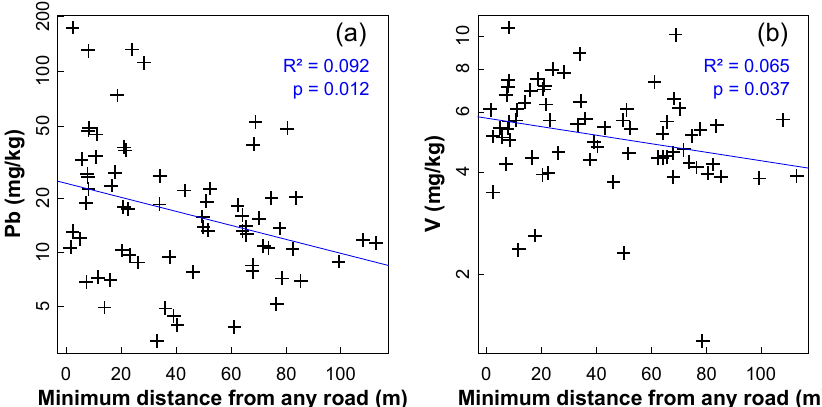
Figure 8. Weak trends in ( a ) Pb and ( b ) V concentrations in surface soil with distance from roads in Charles Veryard and Smith’s Lake Reserves. Solid blue lines are log-linear models.